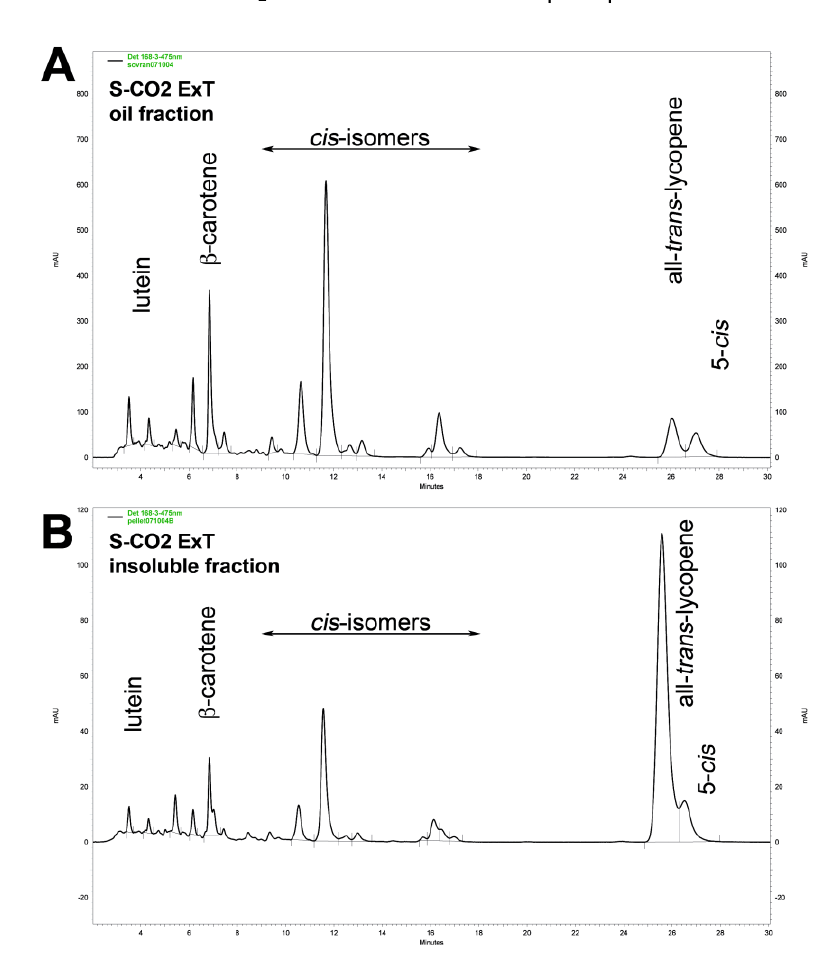
Figure 3. Chromatographic profiles of the high performance liquid chromatography (HPLC) analysis of carotenoids. Oil-fraction ( A ) and insoluble-fraction ( B ) of the oleoresin S-CO ExT extracted from pure tomato powder. Oil-fraction ( C ) and insoluble-fraction ( D ) 2 of the oleoresin S-CO ExTH extracted from tomato/hazelnut powder. Insoluble 2 paracrystalline fraction of S-CO ExT oleoresin after re-precipitation in hexane ( E 2